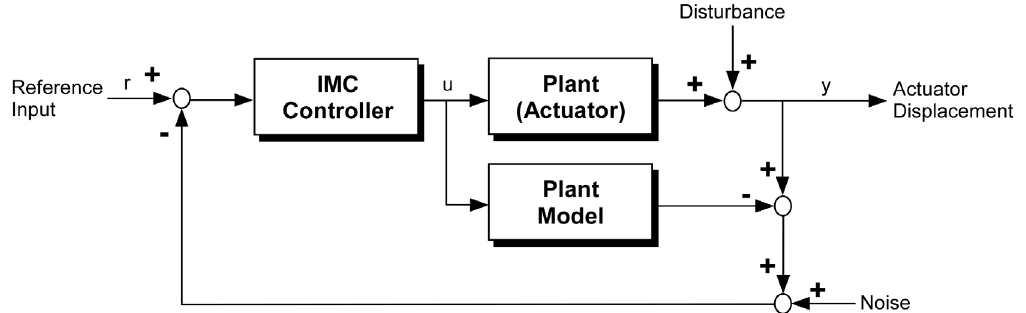
Figure 2. Internal model control (IMC) system.